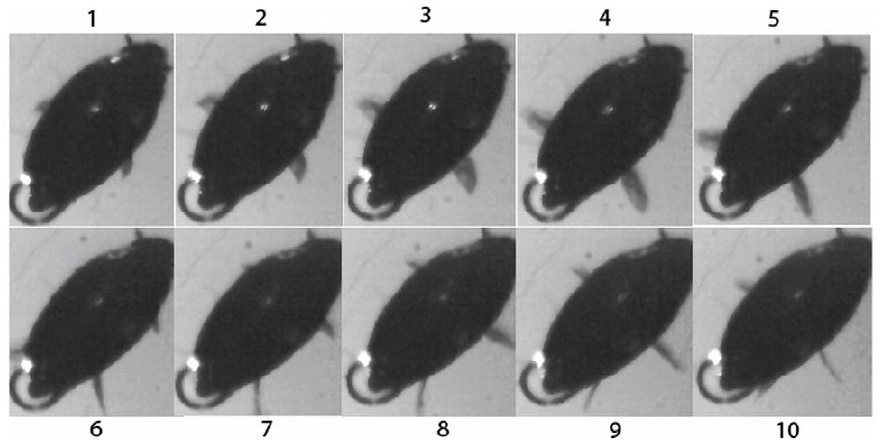
Figure 4. The sequence of one hind leg stroke. In frames 1–5, only the hind leg is visible, with the middle leg emerging in frame 6. In frames 6– 10 it is possible to observe the beating of both legs. During the course of one leg stroke, the effective area of the legs decreases in the horizontal plane, indicating that the effective area for forward propelling increases.